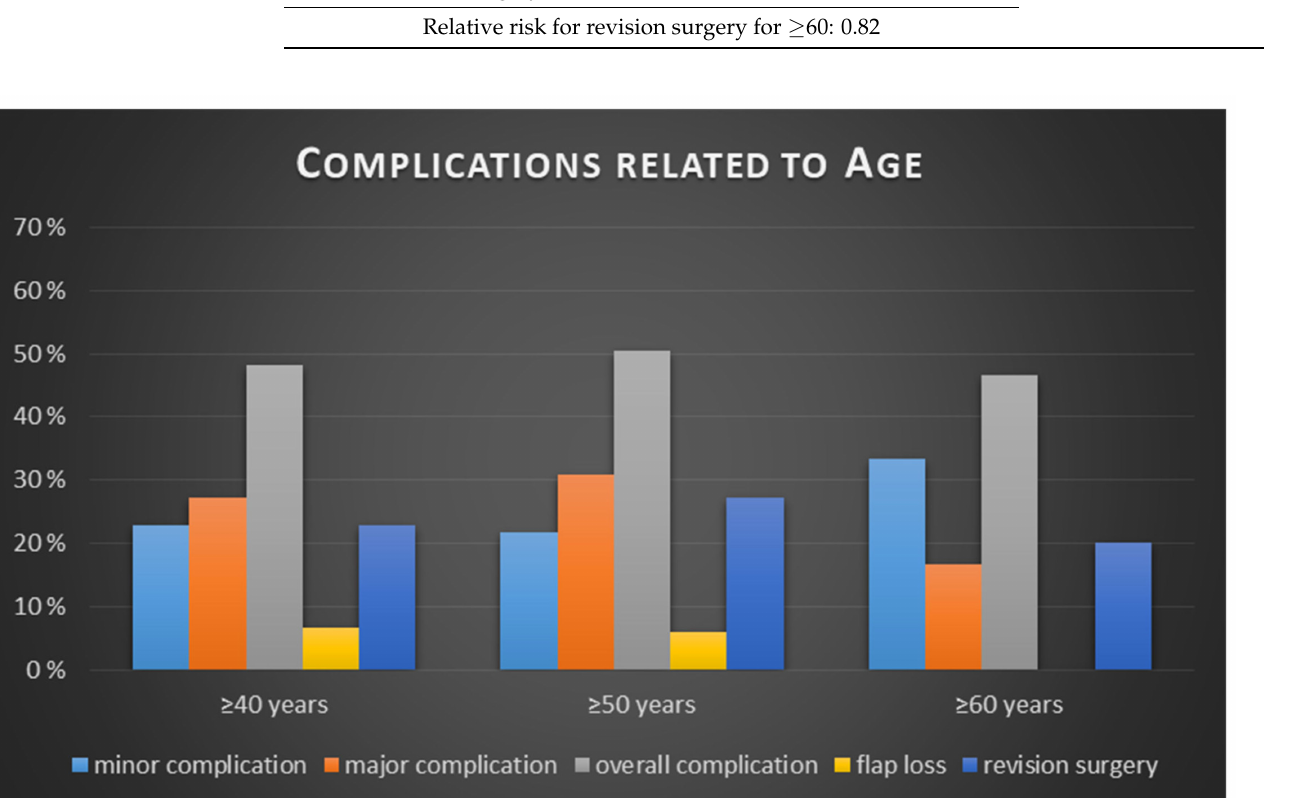
Figure 4. Relationship between age and the percentage of the different complications. Complications were also categorized according to patient BMI (over and below BMI of 25 kg/m 2 ) (Table 4). Regarding minor-, major-, and overall complications, mMinor complication rates, as well as for revision surgeries, no significant difference could be found within the groups. The highest relative risk calculated was 1.21 for major complications for patients with BMI over 25 ( p = 0.460). Table 5 and Figure 5 compare patients with higher BMI and over 50 years of age to younger patients with lower BMI. No significant difference was observed for the occurrence of the calculated complications. The highest relative risk calculation was observed for the major complications (RR 1.36, p =